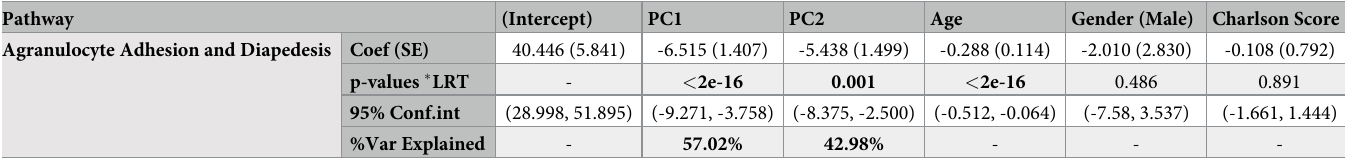
Summary of multivariate linear regression models with COVID-19 severity as the outcome using COVID-19 patients only, and the principal components used to summarize the enriched pathways associated with disease severity status as the predictors. The models are also adjusted for the clinical covariates age, sex and Charlson comorbidity score. P-values for significance are determined via the likelihood ratio test